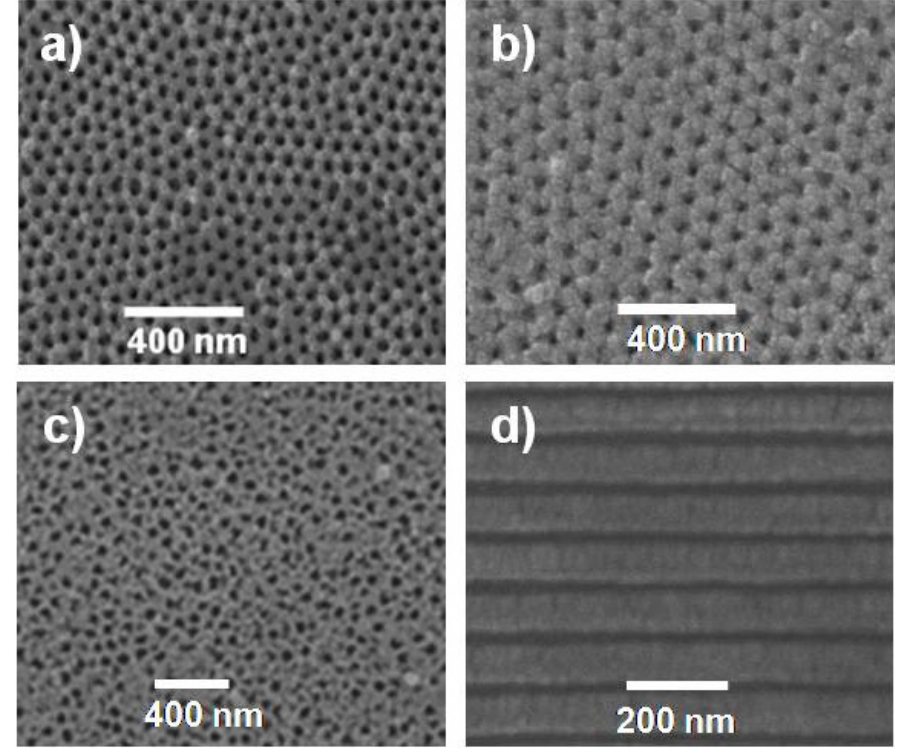
; ( c ) Anopore; and ( d ) cross-sectional 2 . 2